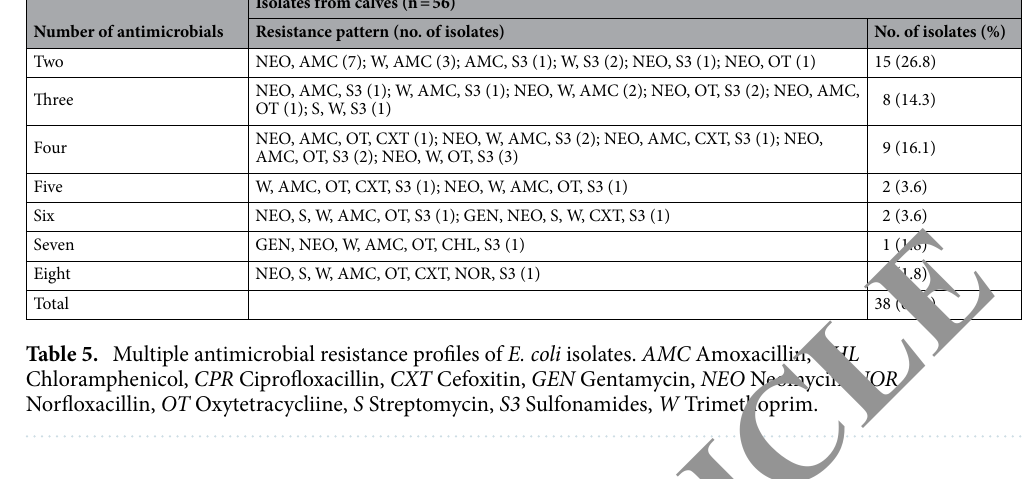
Resistant level of Pathogenic strain harboring virulence factor genes (%) Antimicrobials